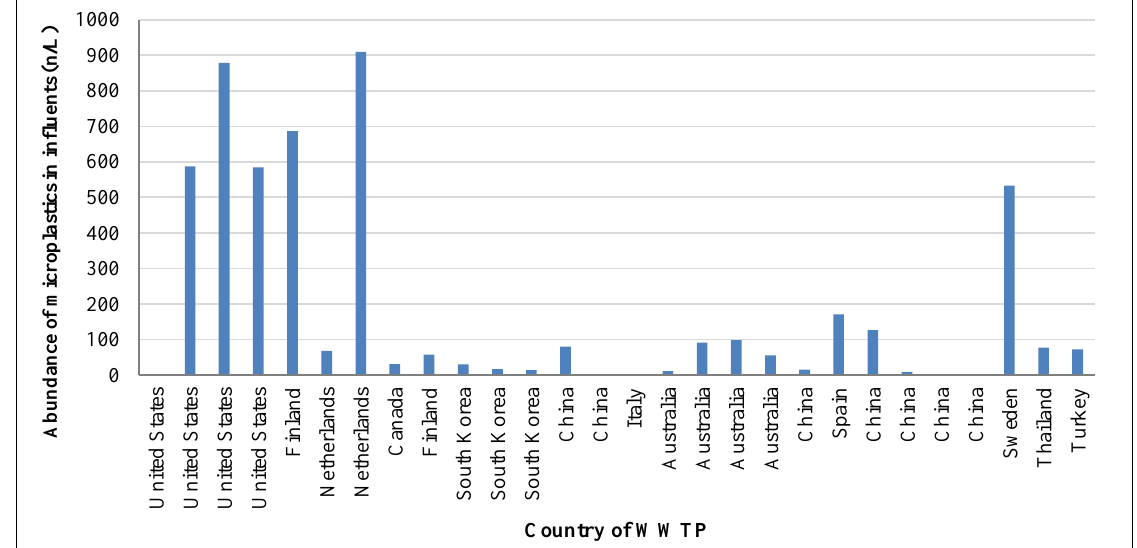
Figure 3. Abundance of microplastics in the influents of WWTPs by country